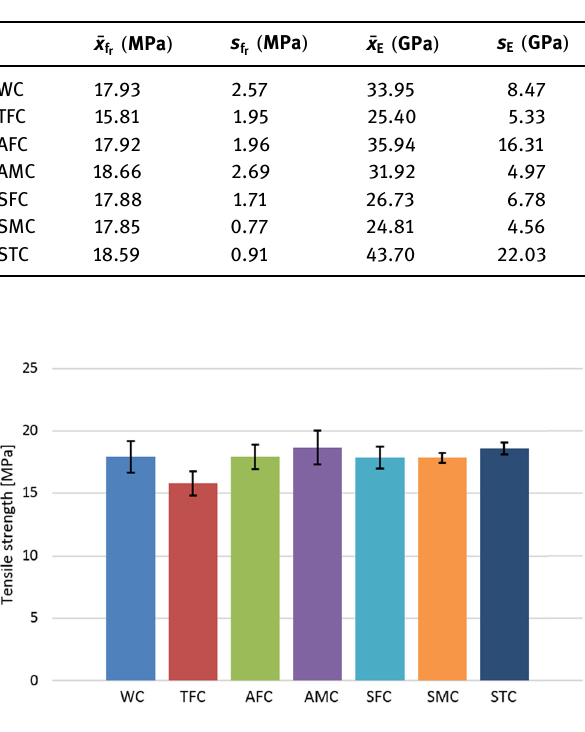
Figure 3: Results for tensile test.